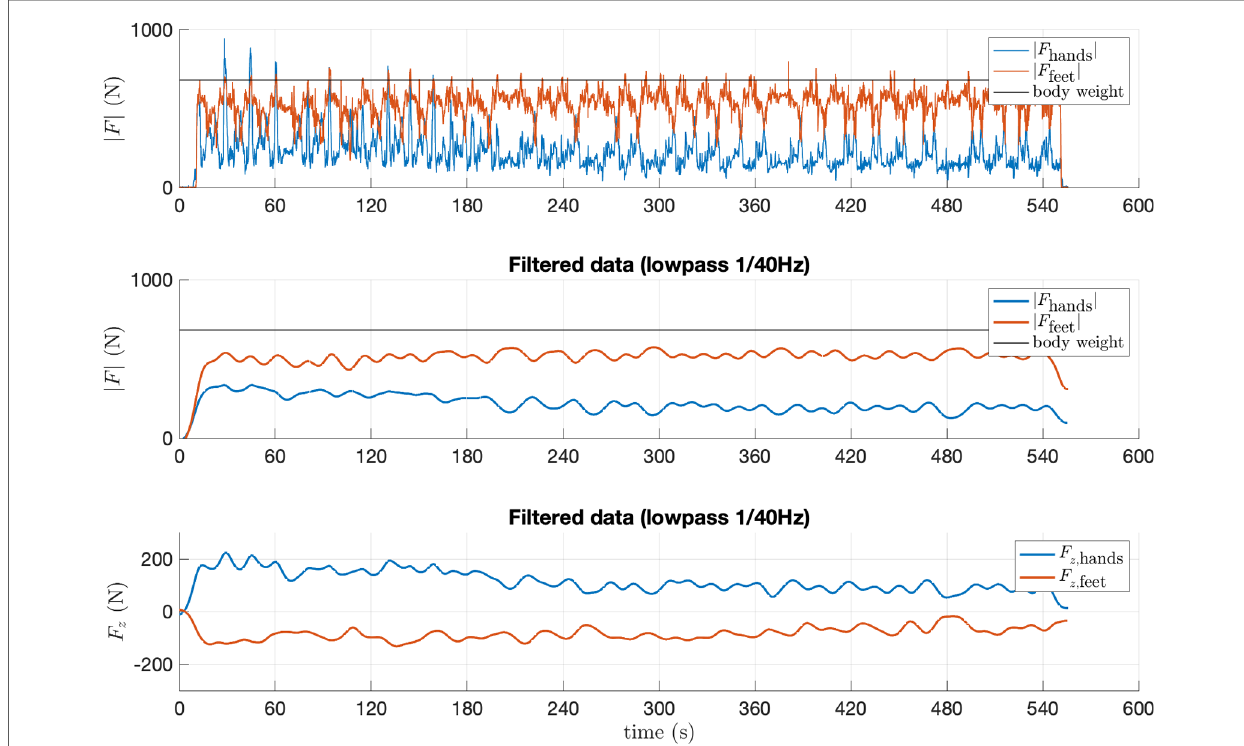
FIGURE 9 The two top panels display the magnitude of the total force measured on holds tagged Hands and Feet , during the trial with Climber 4, which lasted about 9min. In the top panel, the force magnitude is plotted without prior fi ltering, in the central panel it is low-pass fi ltered at 1 = 40Hz. The bottom panel shows the sum of the F z components (orthogonal to the climbing wall, positive outward) measured on all handholds (blue) and footholds (red), low- pass fi ltered at 1 =